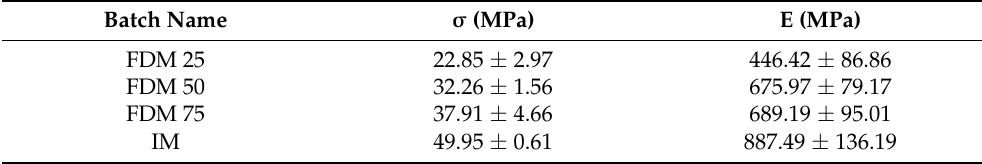
The test results, including mean and standard deviations, of the maximum tensile stress/ strengths ( σ ) and Young’s Modulus (E) for all ABS samples are tabulated in Tables 5 and 6: Table 5 compares full FDM and IM samples, and the HYM samples are presented in Table 6. Table 5. Average tensile test results for all FDM and IM batches, whose standard deviations have been shown in the brackets.